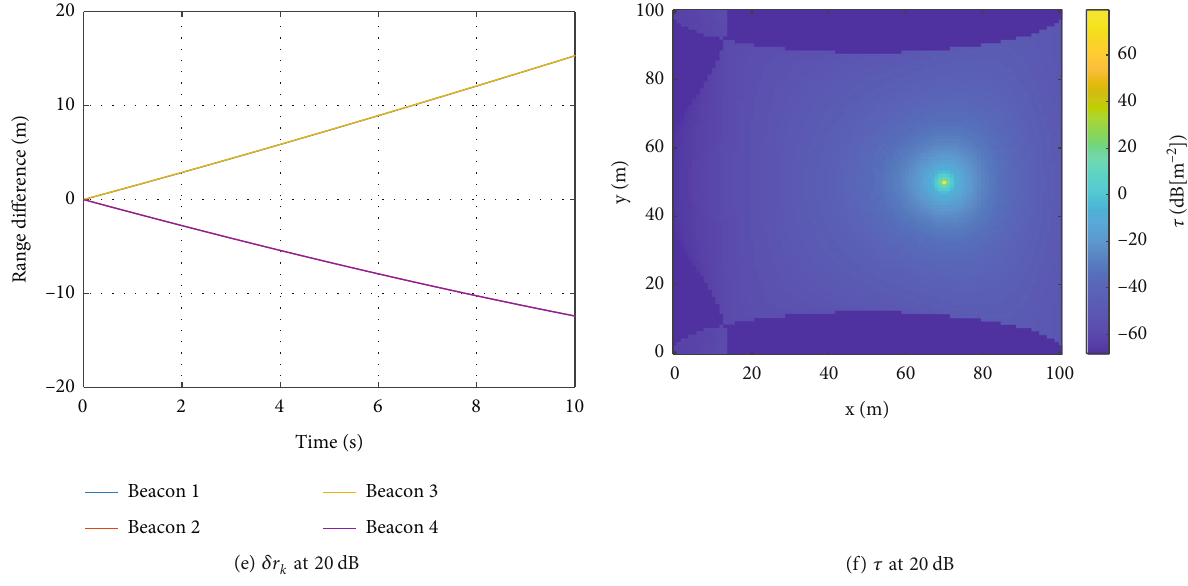
τ of straight Figure 7: Range di ff erence δ r k and distribution of target function di ff erence of Φ ½ k (cid:2) and Φ ½ k − 1 (cid:2) . Assuming that the sampling rate is high enough that the absolute value of phase incre-